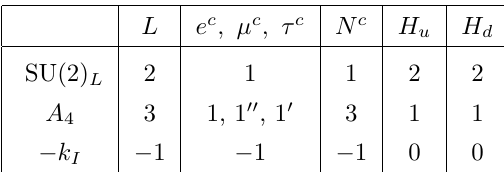
Table 1 . The charge assignment of SU(2) L , A 4 , and the modular weight (cid:0) k I